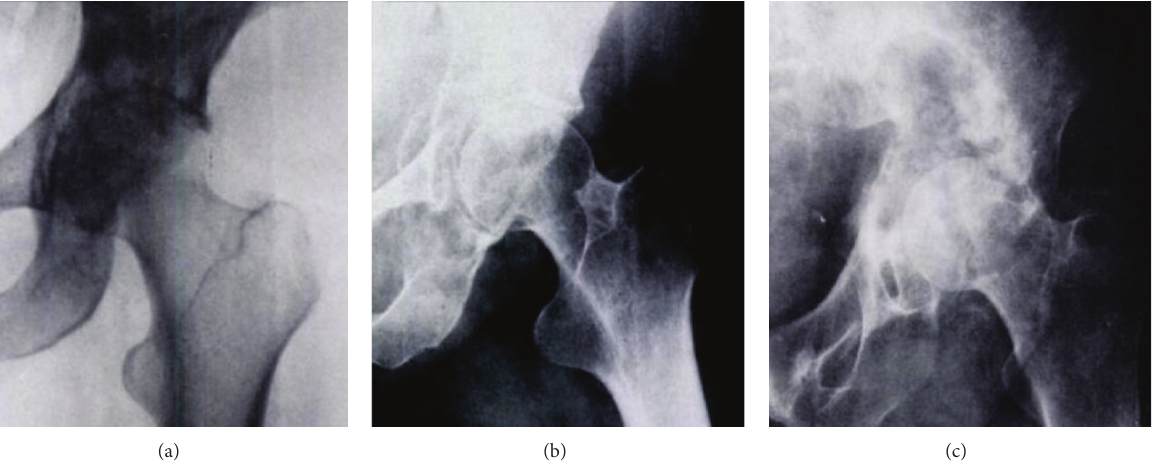
Figure 4: Classification of acetabular defects according to Harrington. (a) Integrity of medial and superior periacetabular bone (Group I). (b) Medial wall insufficiency (Group II). (c) Medial wall and supra-acetabular destruction (Group III). Group IV (no image): total collapse of acetabulum.